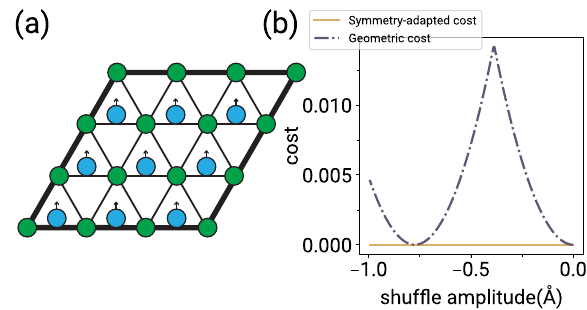
Fig. 4 Geometric cost versus symmetry-adapted cost. A compar- ison of the symmetry-adapted costs against the geometric costs when mapping the O 0 structure with varying shuf fl e amplitude onto a reference O 0 structure. a A schematic of the O 0 crystal structure. The arrows signify a shuf fl e mode of the triangular layer of blue atoms between rigid triangular layers of green atoms. b Comparison between the symmetry-adapted and geometric